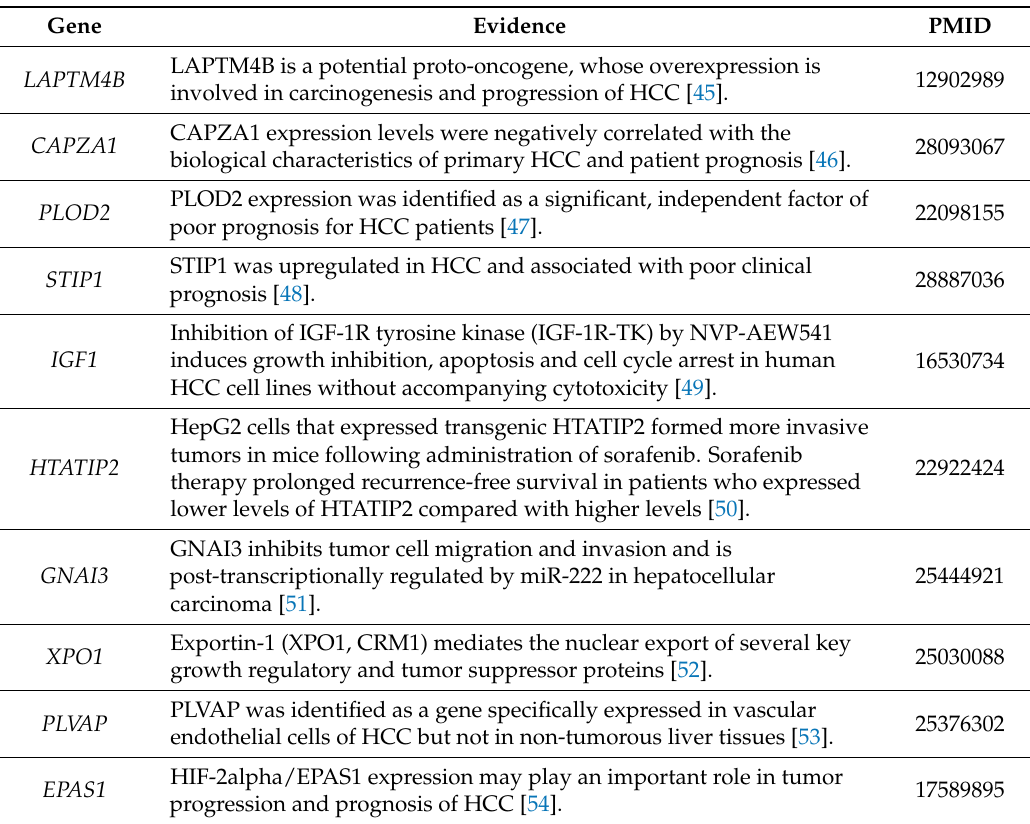
Table 3. Analysis of LIHC data: representative identified